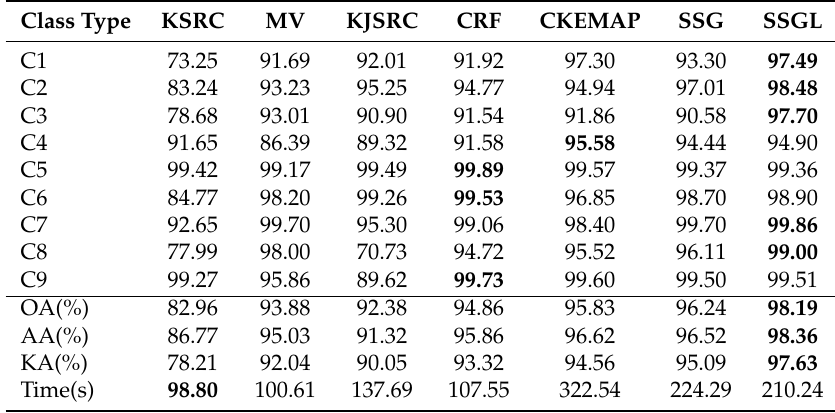
Table 6. Classification accuracies for the ROSIS University of Pavia dataset using different classification methods. The best results are highlighted in